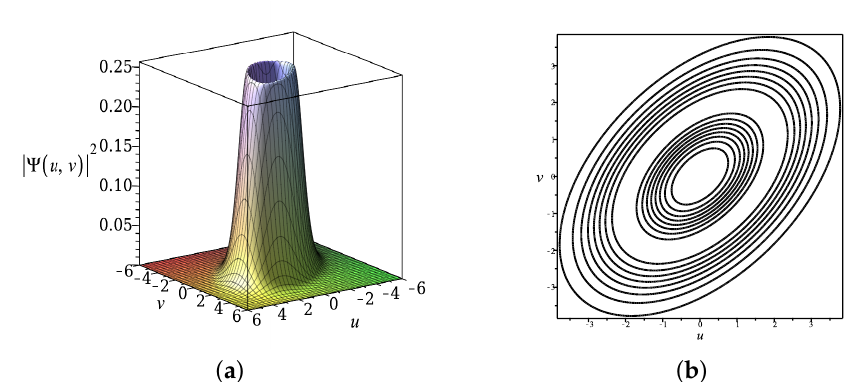
Figure 2. Density plot- ( a ), and contour plot- ( b ), of a wave packet. These figures are plotted for numerical values ω = 1, β 1 = 1, β 2 = π /6, η = 1, δβ 1 = 0.1 and δβ 2 = 3 π